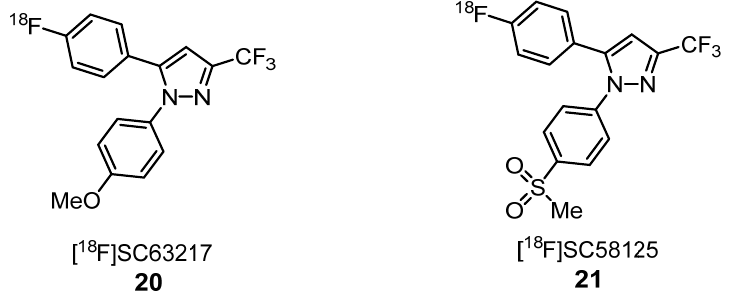
Figure 8. [ 18 F] ‐ labeled pyrazoles as probes for COX ‐ 1 20 and COX ‐ 2 21 [51].